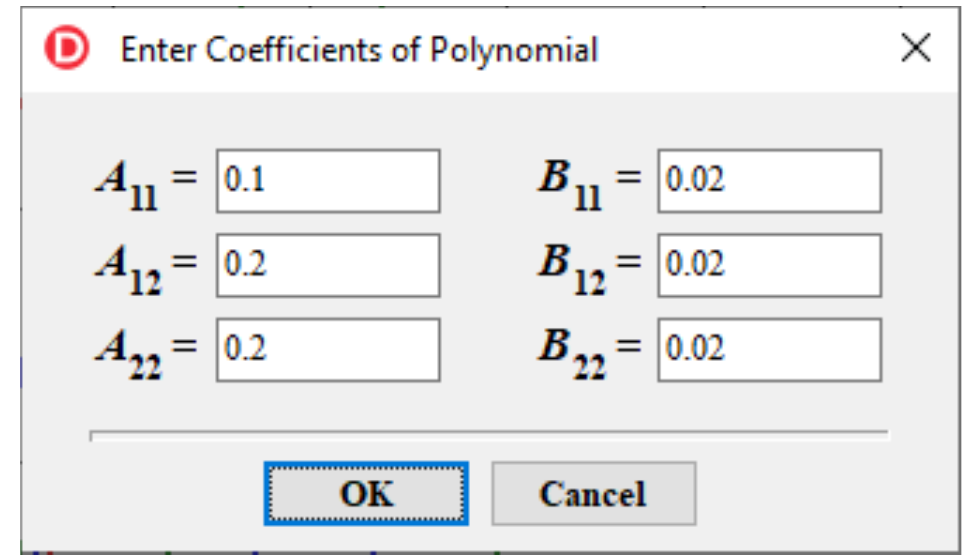
Figure A1. K-matrix scattering amplitudes The parameters in the screenshot in Figure A1 are: